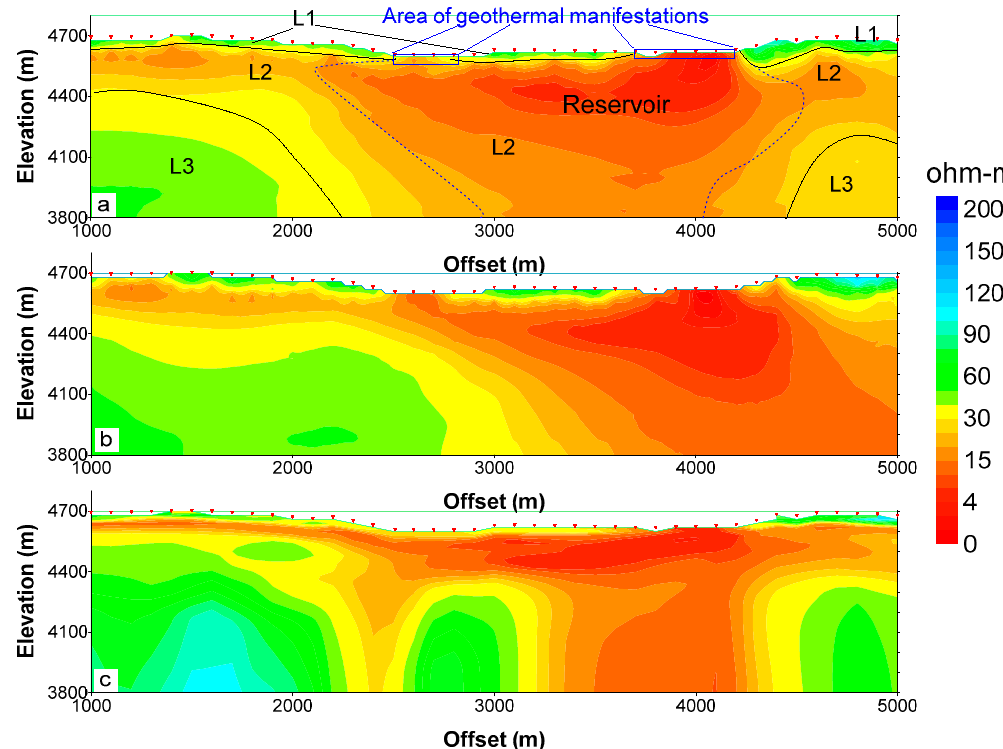
Figure 3. Comparison between Bostick conversion of ( a ) the XY direction, ( b ) the YX direction, and ( c ) nonlinear conjugate gradient inversion (NLCGI) results for an AMT section ((Line1 as shown in Figures 2 and 5). The black solid line outlines the geo ‐ electric layers (L1 to L3). The blue dashed line shows the geothermal reservoir interpreted from the AMT results.